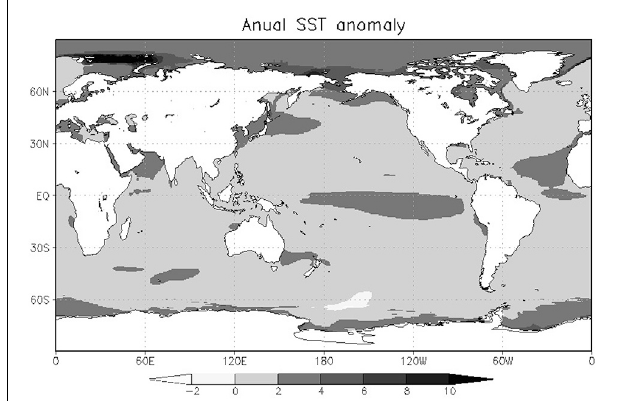
FIGURE 6 | Difference in the SSTs ( ◦ C) used for present (1980–1989) and future (warmer) climate (2080–2089) model simulations.